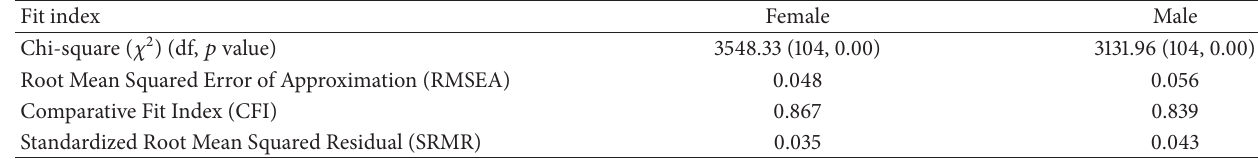
Table 3: Goodness of model fit indices for confirmatory factor analysis for models of active ageing for older persons in Thailand.